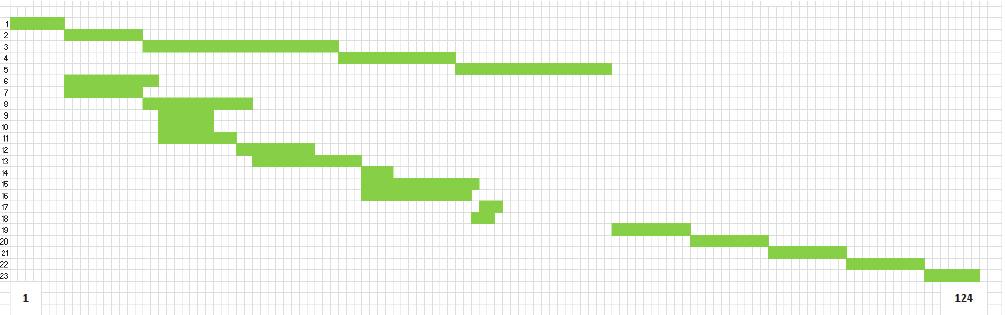
Fig. 15. Gantt chart of the validating experiment after using the proposed forward